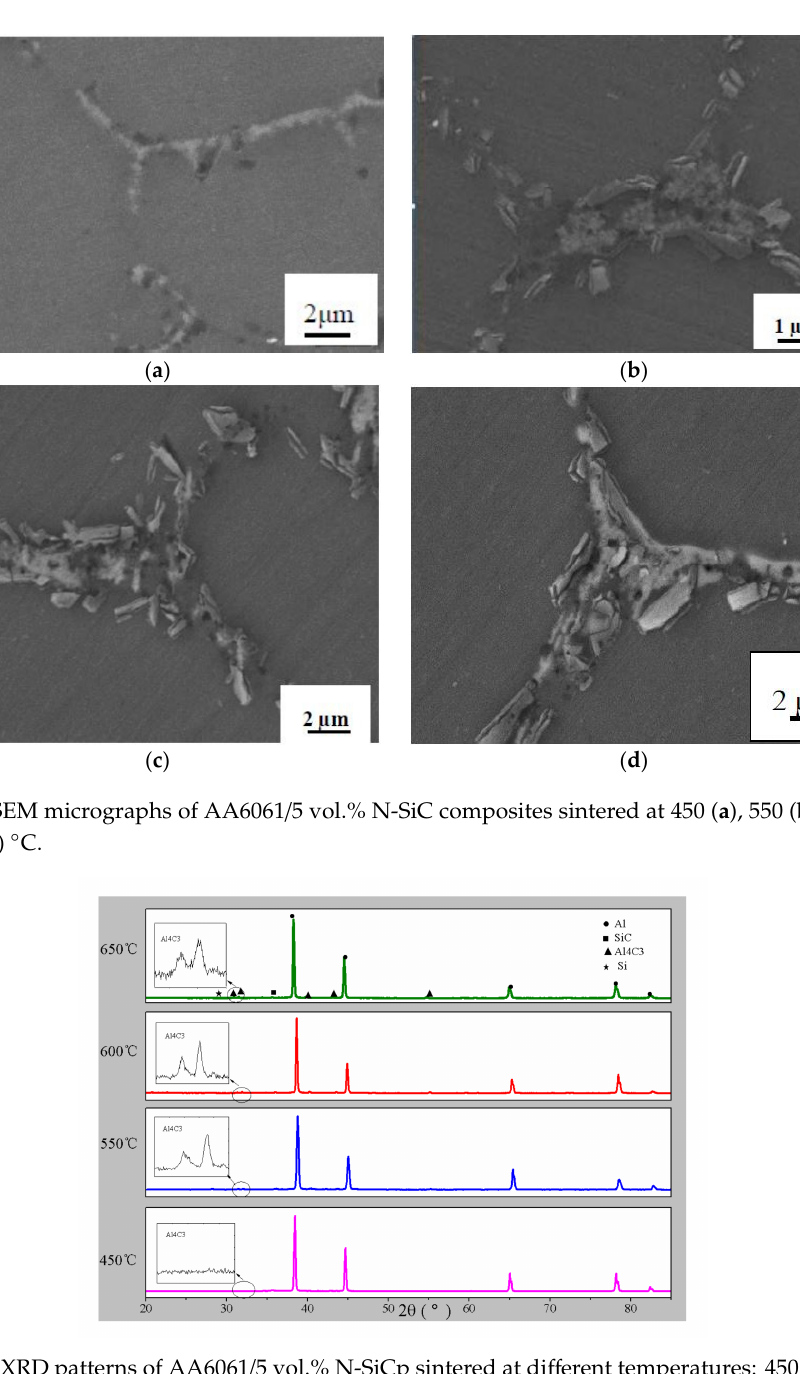
Figure 10. XRD patterns of AA6061/5 vol.% N-SiCp sintered at different temperatures: 450, 550, 600, and 650 °C.